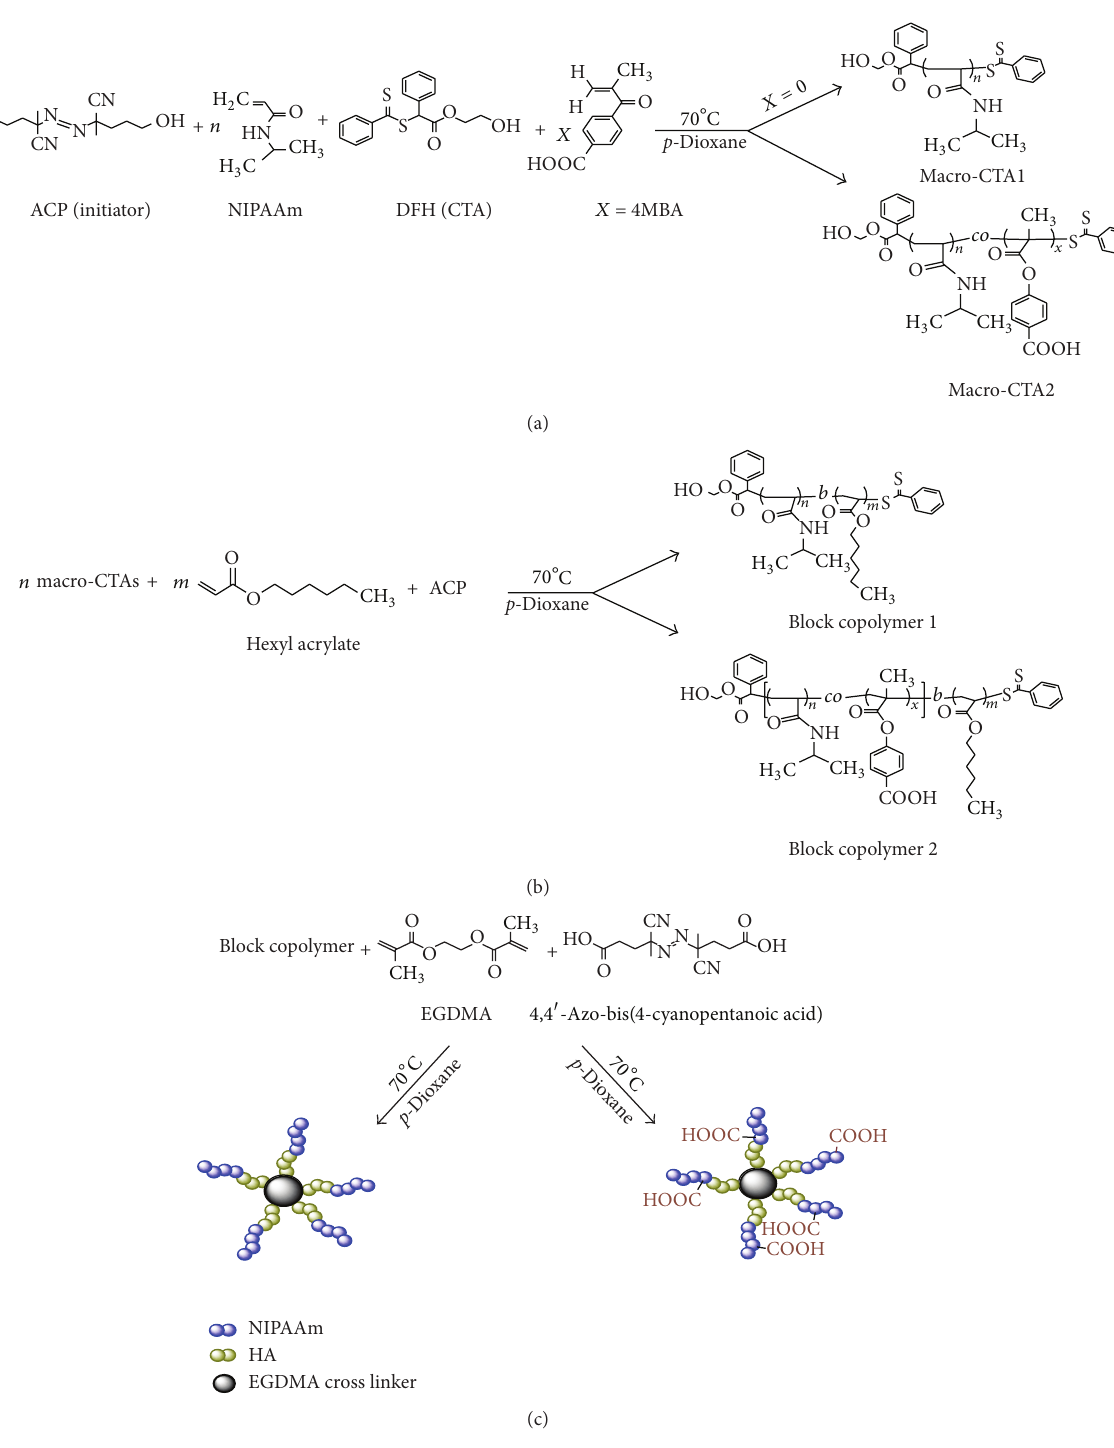
Figure 1: Synthetic routes to obtain pH and temperature sensitive star